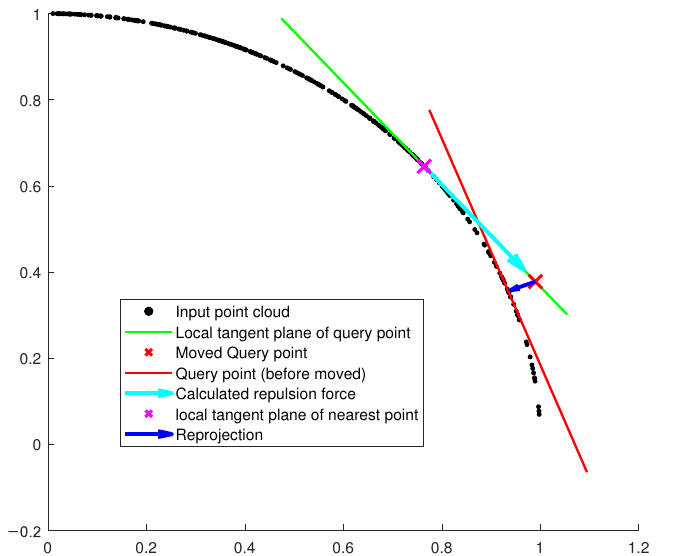
Figure 2. PCA projection restrains the surface approximation error when moved points shift away from the input point cloud’s surface. By using the PCA projection, we project the moved points to the nearest local